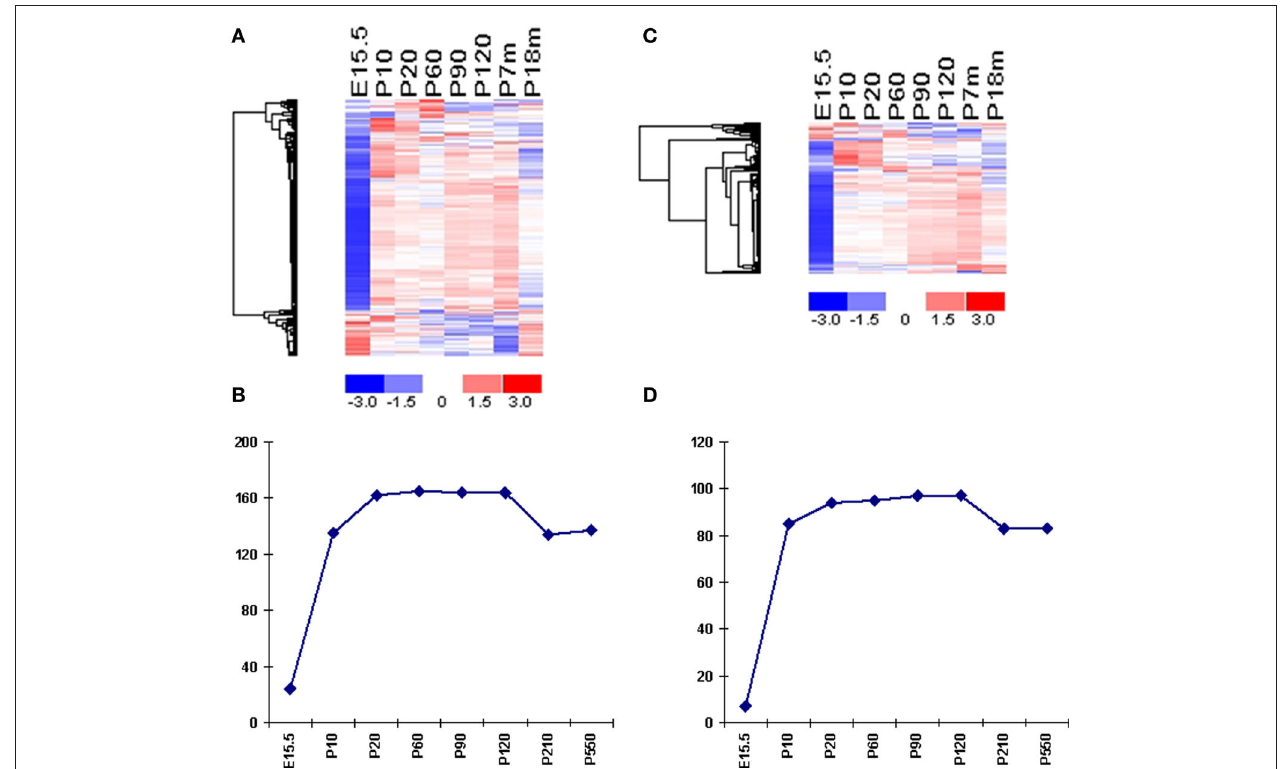
FiGuRe 4 | Temporal expression of VR genes. (A) Expression profiles of mouse V1R genes from different ages are plotted in the same manner as in Figure 2 . Samples are listed according to the age, and genes are shown according to the clustering result. One sample per time point is used in this analysis. Mean of the expression values at each time pointed were used for clustering. One representative probe set was used for each VR gene. In total,